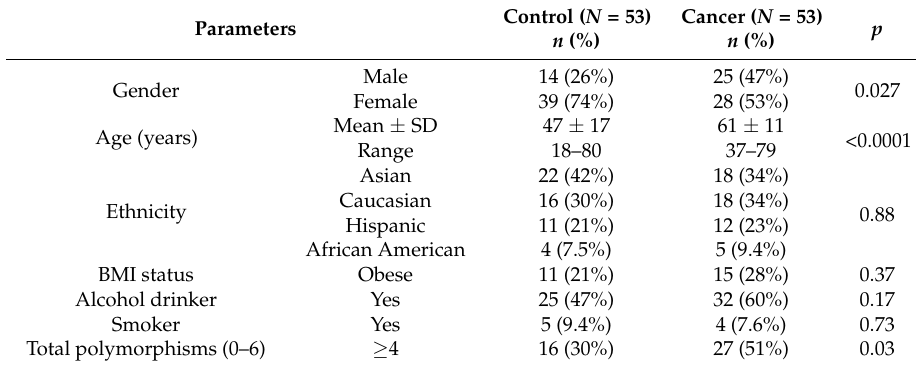
Table 1. Comparisons of demographic/environmental factors between the control and cancer groups.